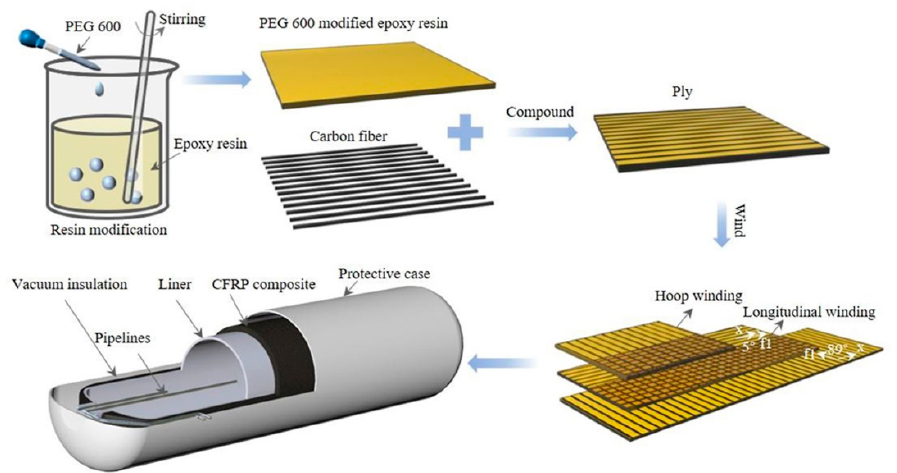
Figure 12. Properties improvement of a composite layer of a cryo-compressed hydrogen storage vessel [72].